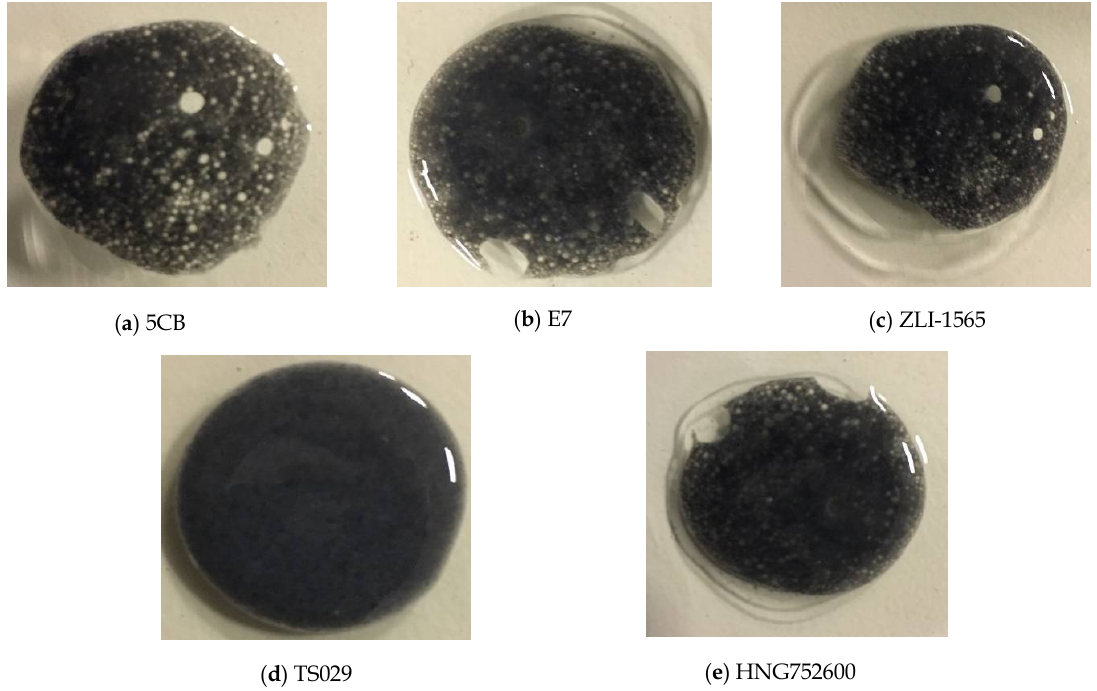
Figure 1. The mixture of polydimethylsiloxane (PDMS); multi-walled carbon nanotubes (MWCNTs); and ( a ) 5CB, ( b ) E7, ( c ) ZLI-1565, ( d ) TS029, and ( e ) HNG752600 after the mixture was stirred for 60 min and then left standing for 30 min.